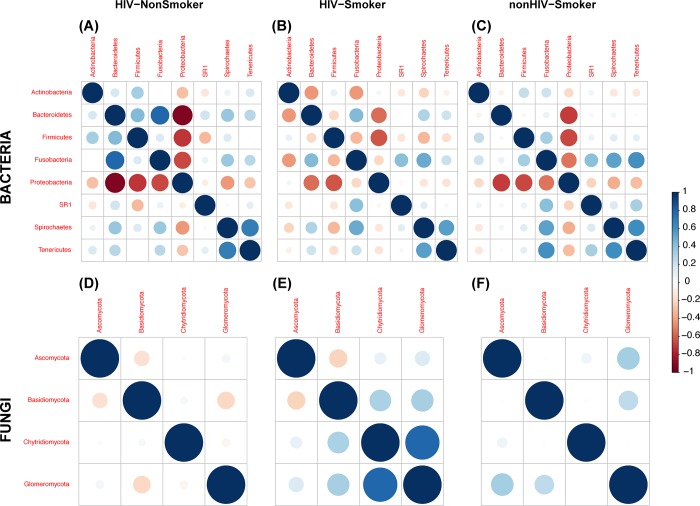
Intra-kingdom correlations within the bacteriome and mycobiome for (A,D) HIV-infected non-smokers, (B,E) HIV-infected smokers, and (C,F) uninfected smokers. Spearman’s correlation for each comparison was determined for the three groups. Blue circles indicate positive correlations; red circles indicate negative correlation; diameter of circles represent the absolute value of correlation for each pair of the microbe-microbe matrix.